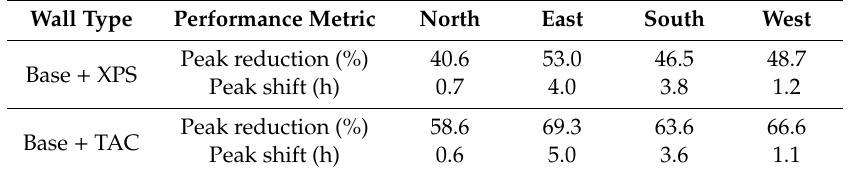
Table 4. Calculated average peak heat gain reduction and average peak shift during July in Phoenix.